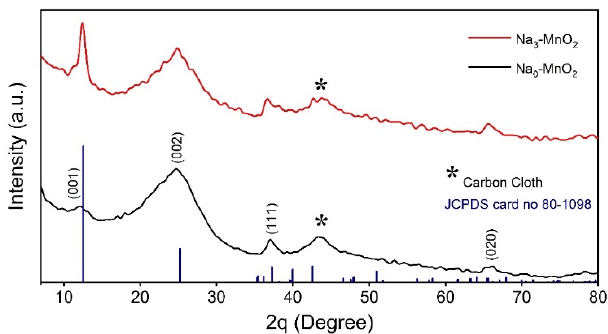
Figure 1. XRD patterns of Na 0 -MnO 2 and Na 3 -MnO 2 .